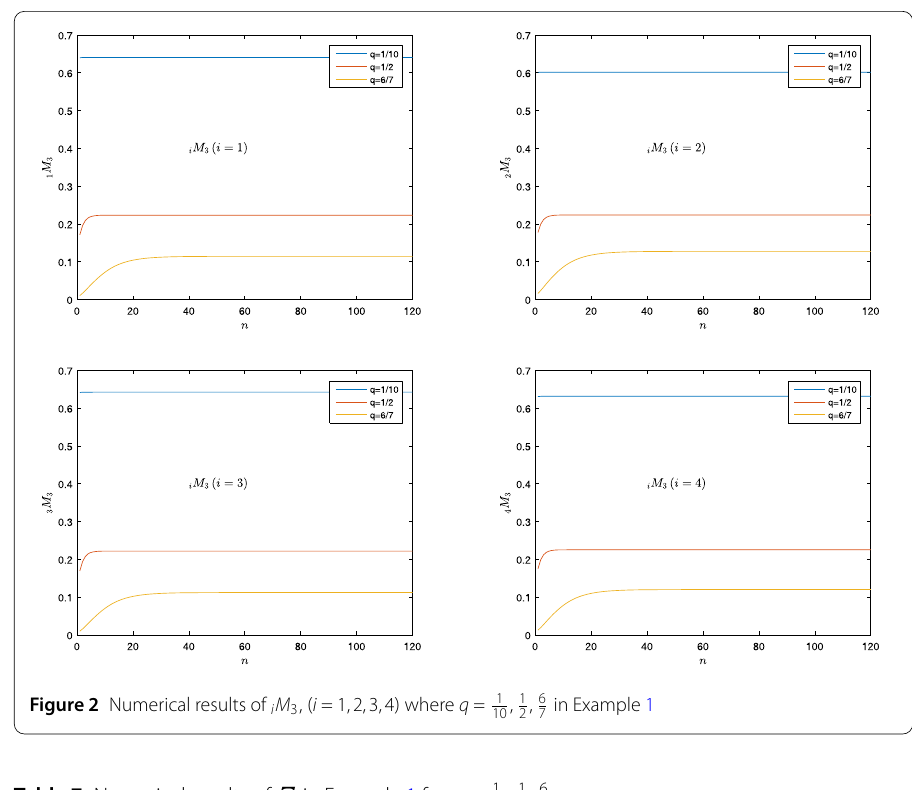
Table 7 Numerical results of Ξ in Example 1 for q = 1